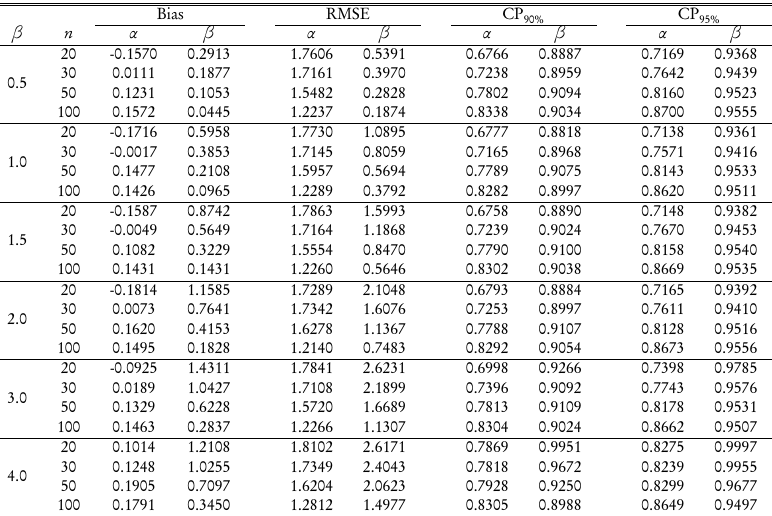
Estimated bias, root mean-squared and coverage probability α and β ( α = 2.0